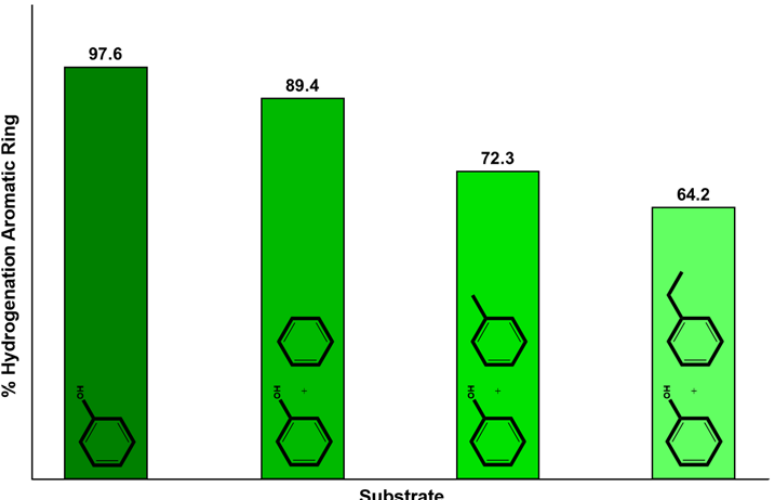
Figure 4. Competitive catalytic hydrogenation of phenol and phenol/benzene, phenol/toluene and phenol/ethylbenzene equimolar mixtures at 210 °C under CTH conditions. Adapted from Ref. [125]. Copyright Year 2018, American Chemical Society.